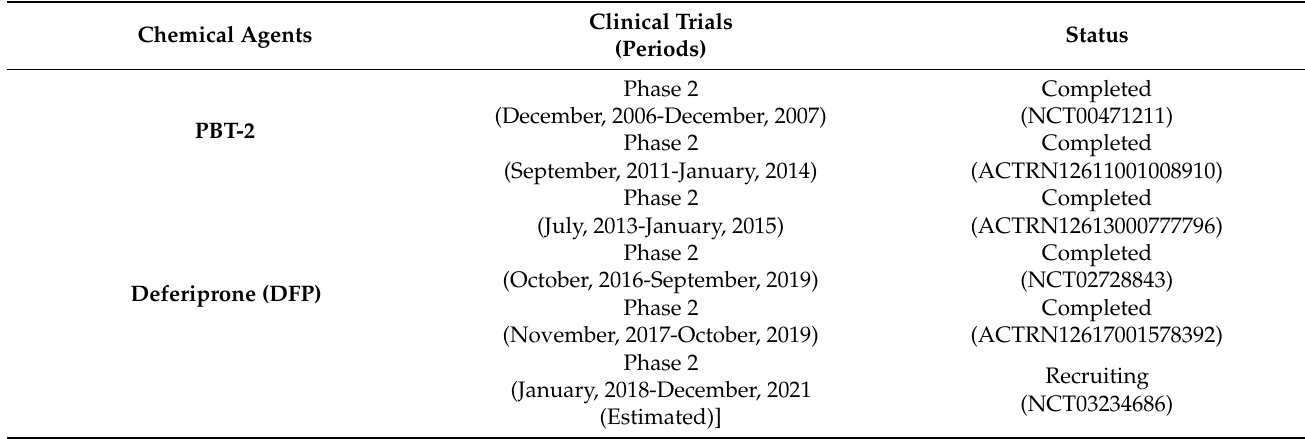
Table 1. Clinical trials of chemical agents. PBT-2 and deferiprone ( DFP ) have been examined their potential as treatments for neurodegeneration.